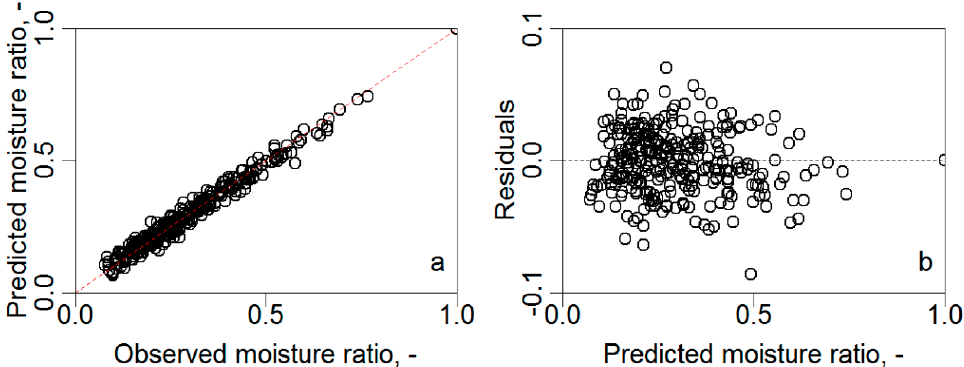
Figure 4. Model performance for MR expressed as a function of ∆ P calculated with Equation (2b), ( a ) predicted MR versus observed MR values are concentrated closely to the perfect fit line of x = y , and ( b ) the residuals are equally distributed and do not show any trend.